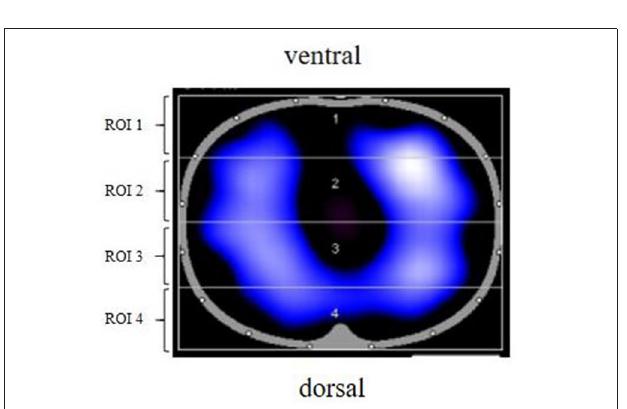
FIGURE 2 | EIT image partition diagram. ROI 1, ROI 2, ROI 3, and ROI 4 were, respectively, from top to bottom. From left to right, right lung and left lung. ROI, region of interest; EIT, electrical impedance